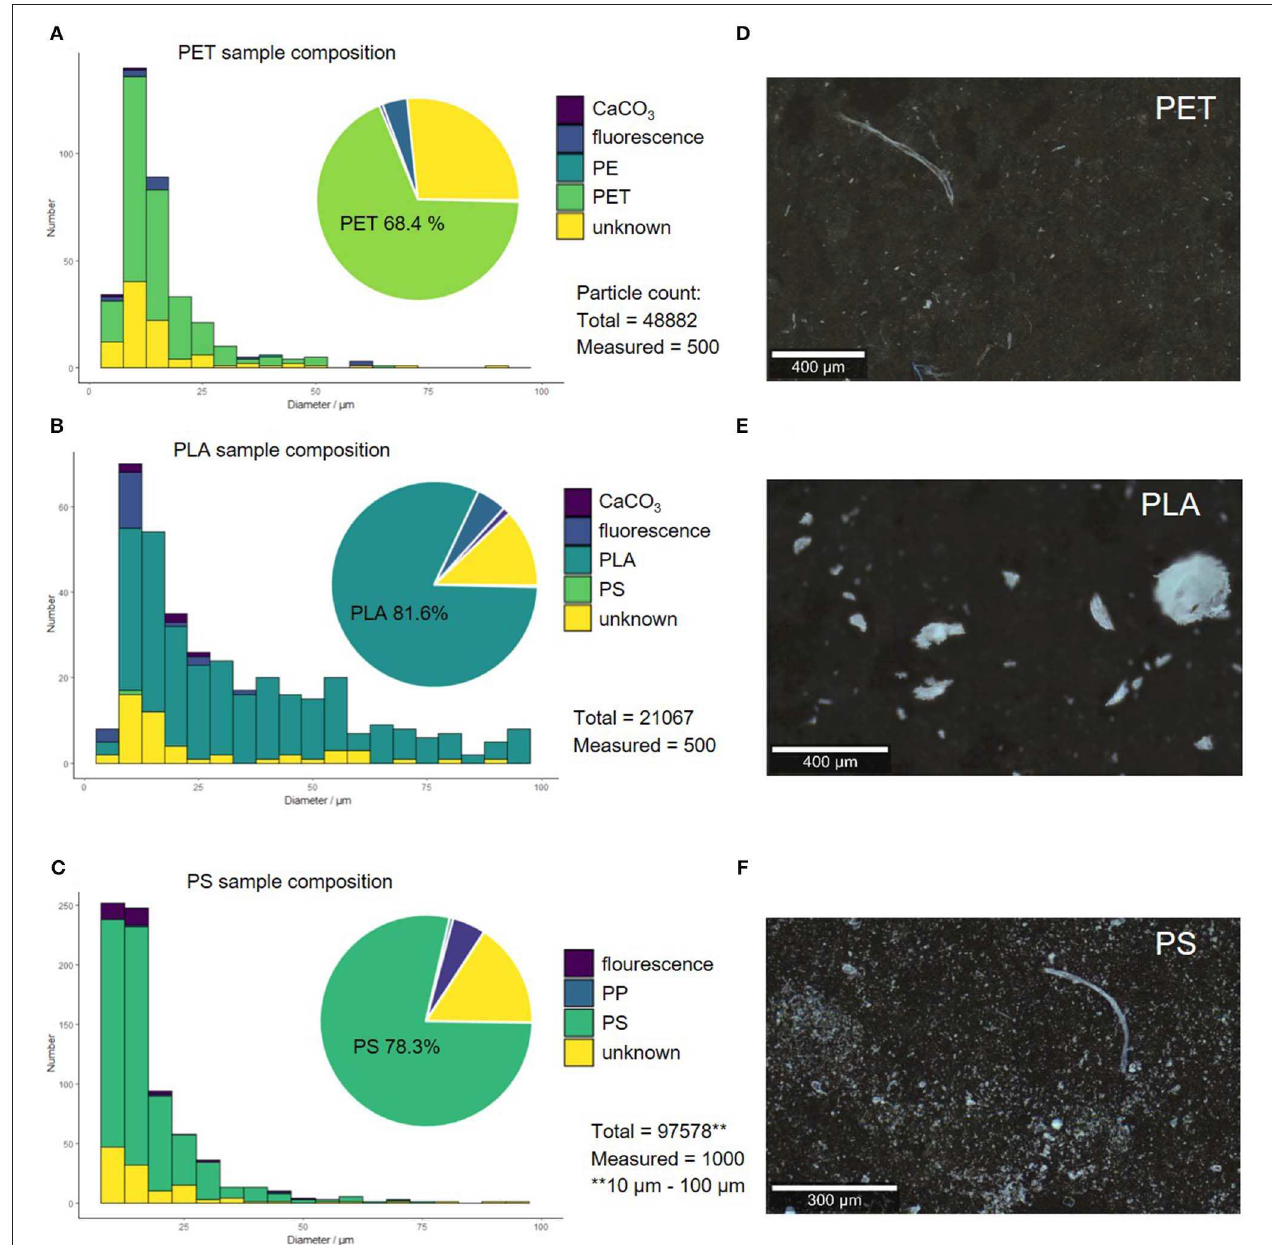
FIGURE 4 | Compound correlated size distribution of replicate 1 by operator 1 for PET (A) , PS (B) , and PLA (C) . Microscopy images of polymer fragments produced through sonication in alkaline solution (replicate 1) PET (D) , PS (E) , and PLA (F)